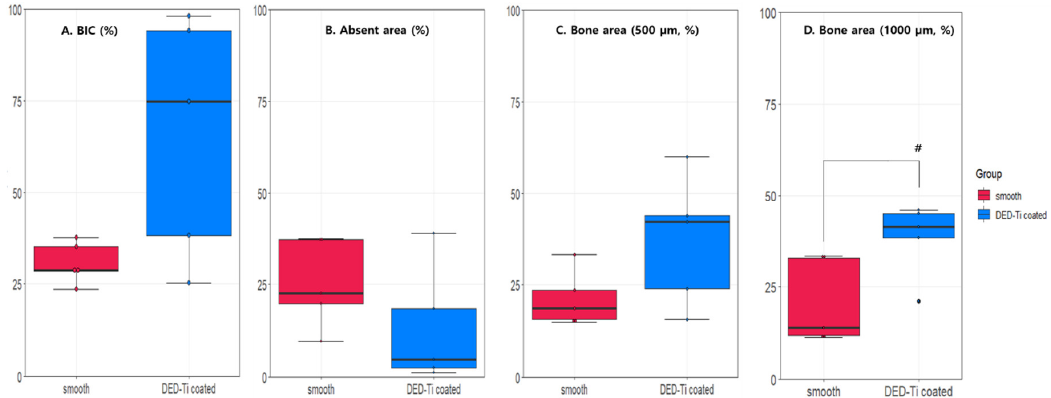
Figure 9. The results of bone histomorphometry. In A: BIC ( p = 0.095), B: absent area ( p = 0.222), and C: 500 µm bone area ( p = 0.095) there were no significant differences between the smooth and DED groups. D: However, in the 1000 µm bone area, the DED group exhibited a significantly higher new bone formation than the smooth group ( p = 0.0317). (# p < 0.05).